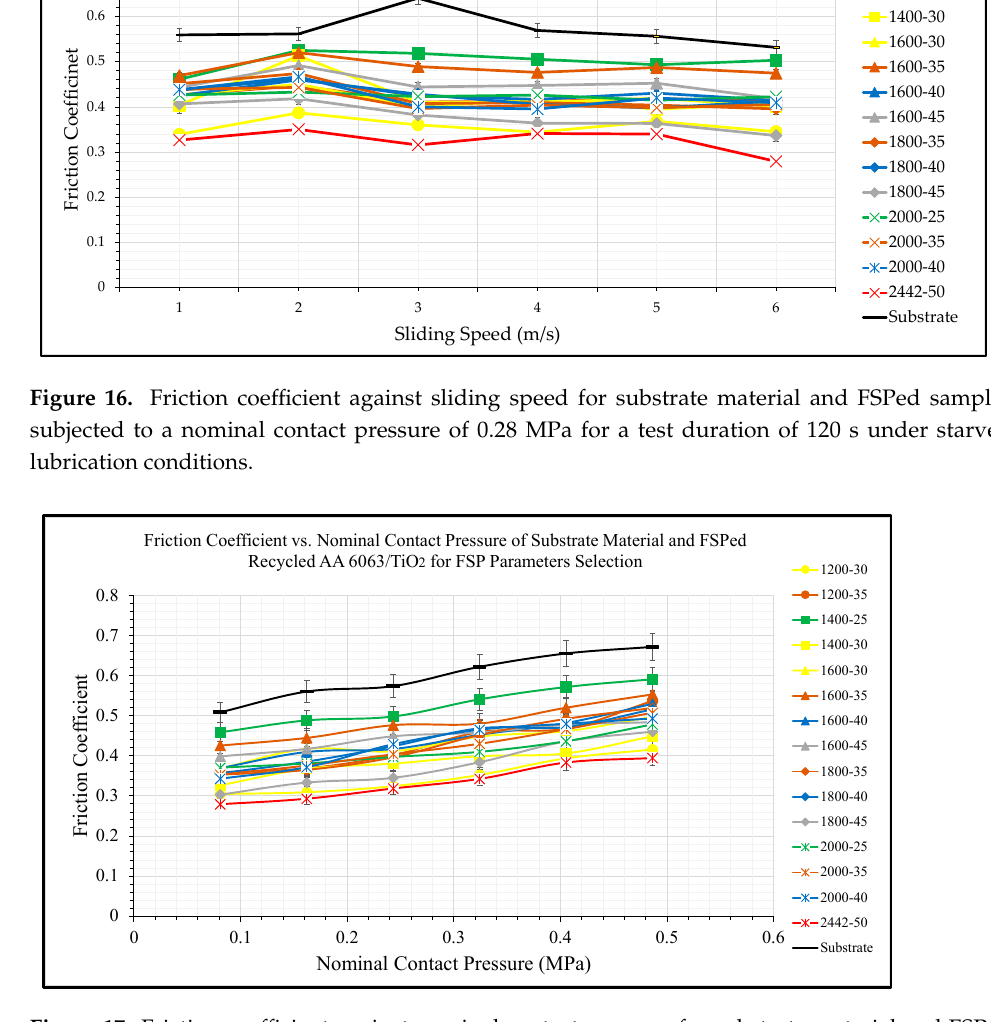
Figure 16. Friction coefficient against sliding speed for substrate material and FSPed samples subjected to a nominal contact pressure of 0.28 MPa for a test duration of 120 s under starved lubrication conditions.